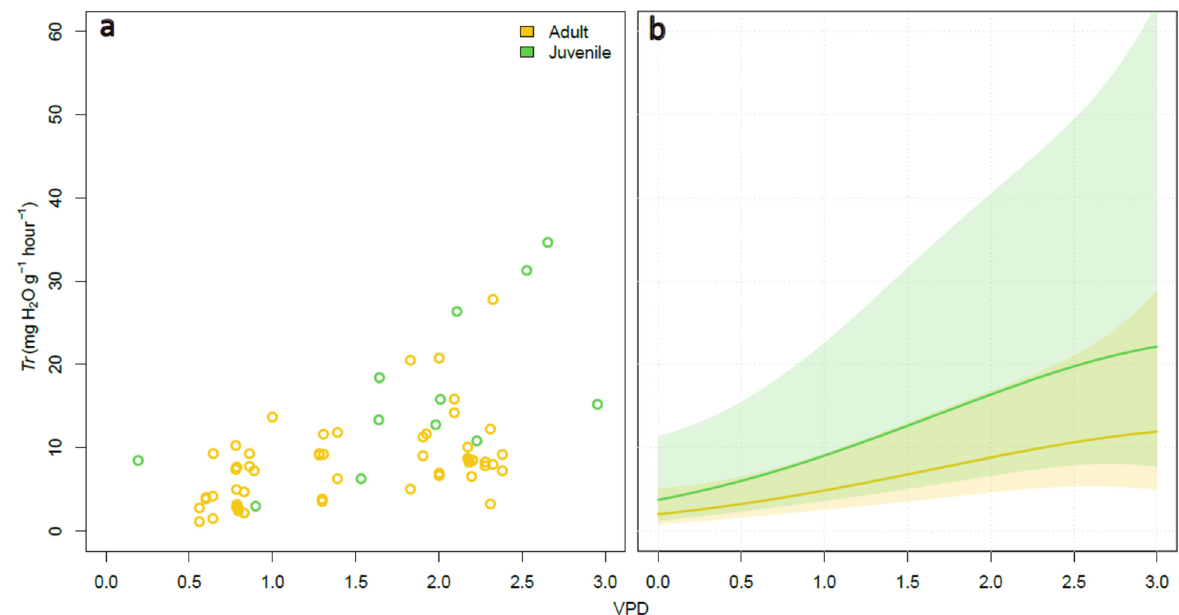
Figure 3. Linear mixed model of the changes in transpiration ( Tr ) of 66 juvenile and adult insects at different VPD. Scatterplot of the measurements ( a ), and model prediction ( b ). The solid lines and shaded areas in ( b ) represent the model prediction and the 95% confidence intervals, respectively.